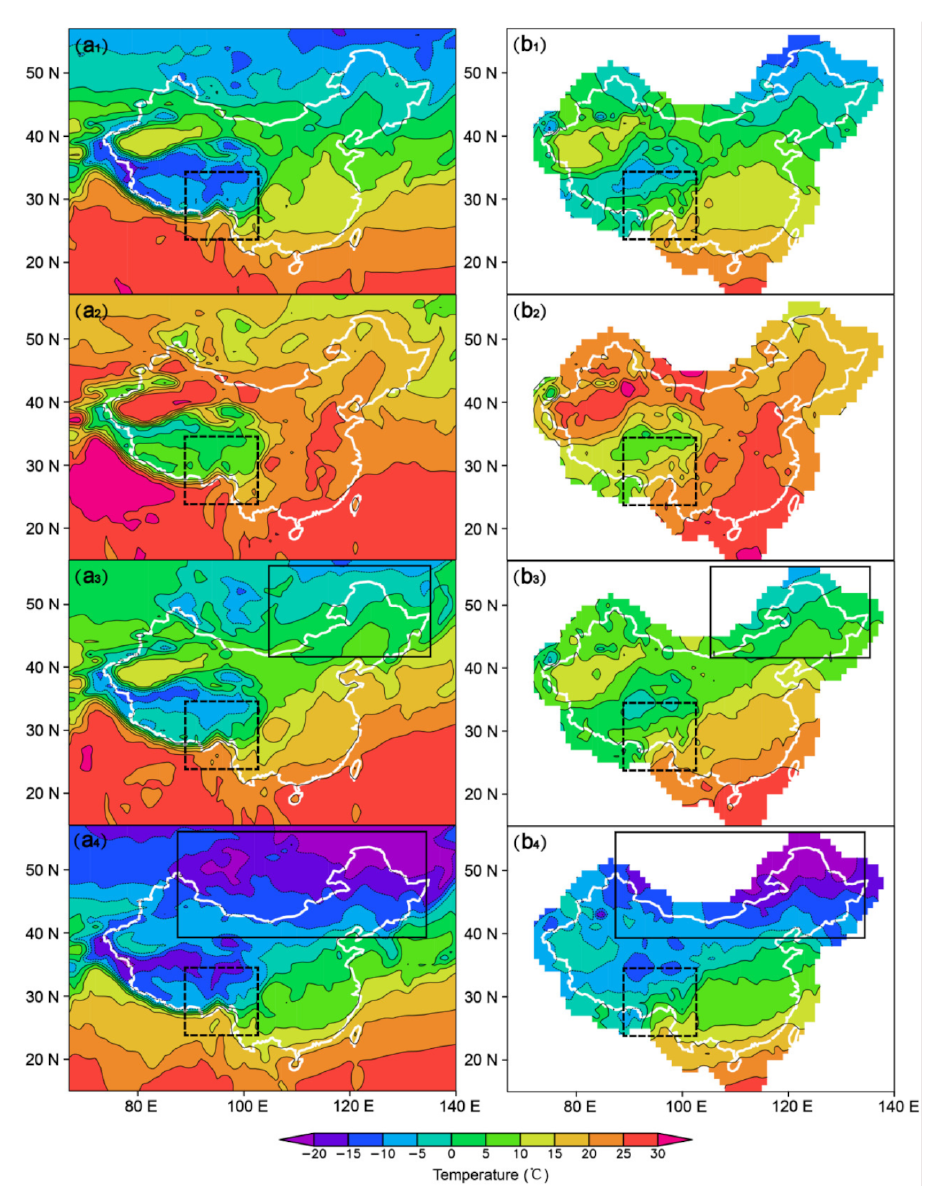
Figure 2. ECMWF-predicted ( a 1 – a 4 ) and reanalyzed ( b 1 – b 4 ) 2 m temperature distributions (shaded; units: ◦ C) of March ( a 1 , b 1 ), June ( a 2 , b 2 ), October ( a 3 , b 3 ), and December ( a 4 , b 4 ) averaged over the three years (2016–2018). The black solid and dashed frames in each panel mark the areas with the predicted temperature being higher and lower than the observation,